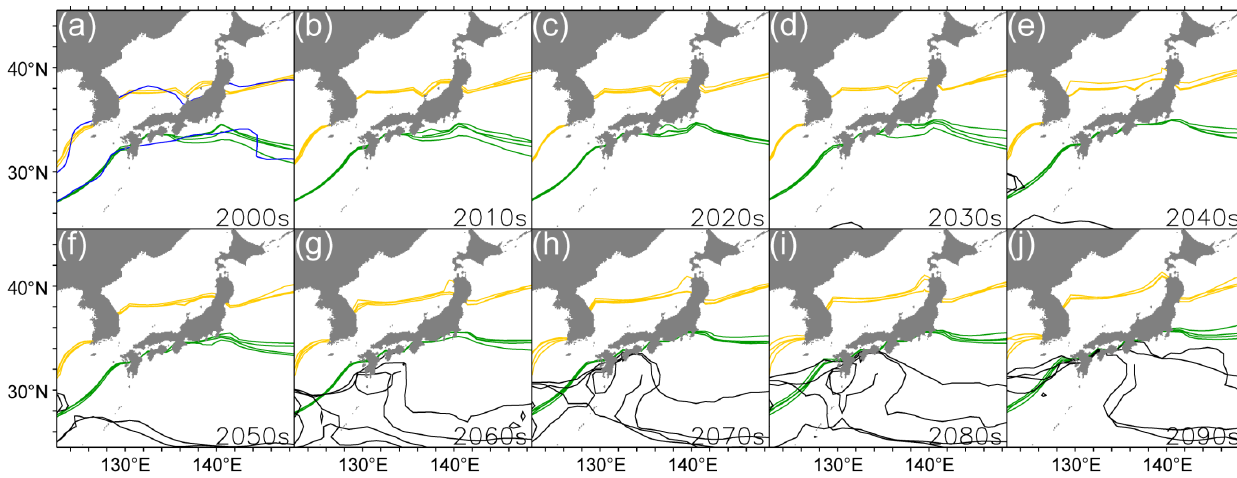
Fig. 7a. Projected 10-yr mean northern limit of the tropical/subtropical coral community (defined by the isothermal lines of SST=18 ◦ C; green lines) and temperate coral occurrence (defined by the isothermal lines of SST=10 ◦ C; yellow lines) defined by SST during the coldest months of each decade in seas close to Japan in 2000s–2090s, obtained by the four climate models. The blue lines in (a) denote the 10-yr mean observed monthly-mean isothermal lines of SST=18 ◦ C and 10 ◦ C during the coldest months, estimated by NOAA OISST. The black lines denote isothermal lines of SST=30 ◦ C during the hottest months.